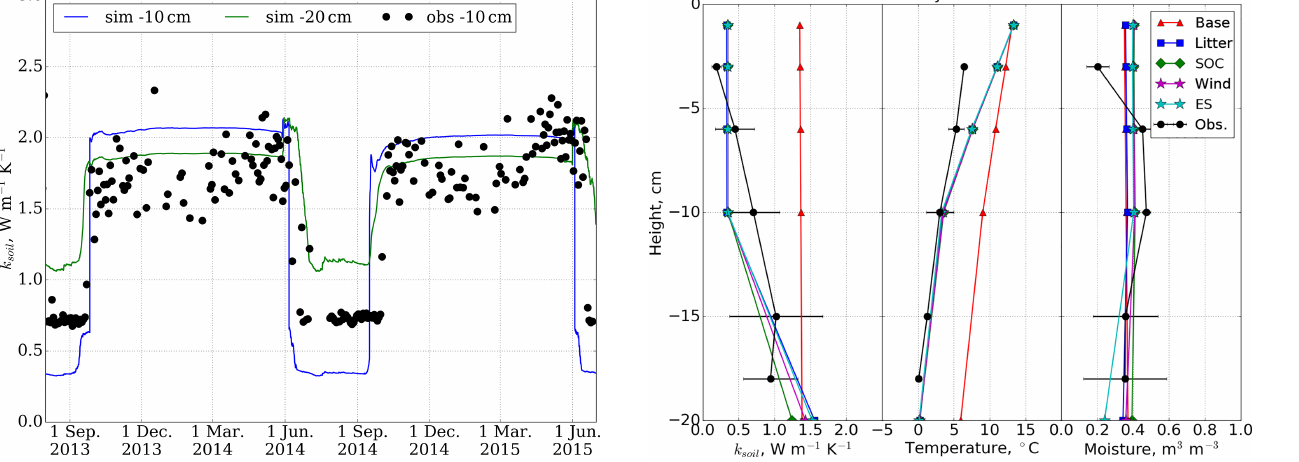
Figure 9. Vertical profiles of k soil , soil temperature and volumetric water content (VWC, labeled Moisture in the figure) measured on 29 June 2014 and simulated in the first 20cm below the surface. Horizontal bars indicate the standard deviation of